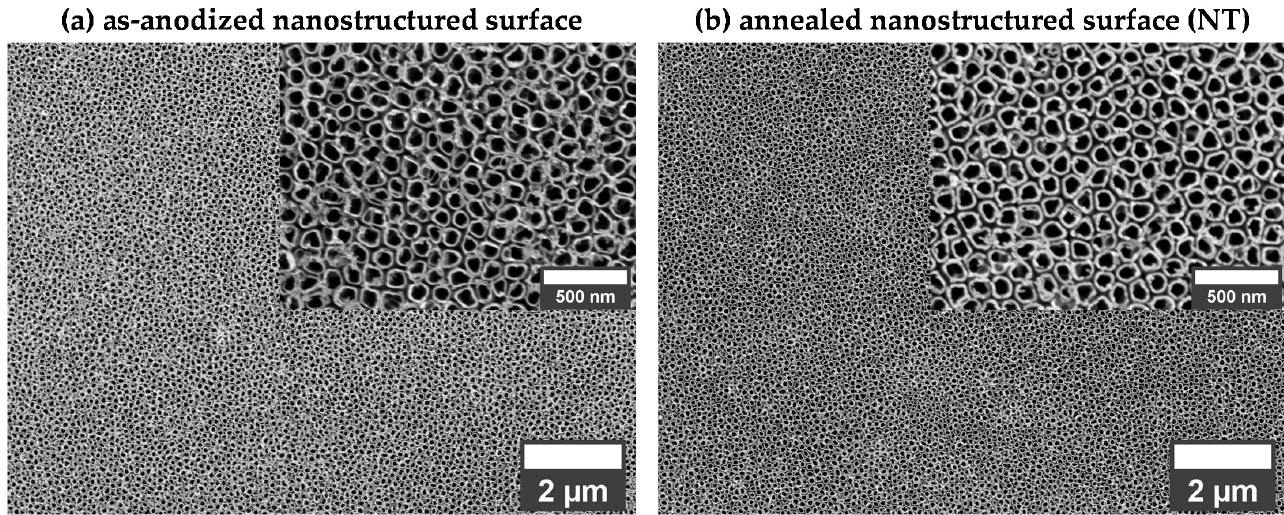
Figure 1. Morphology of the ( a ) as-anodized and ( b ) annealed nanostructured